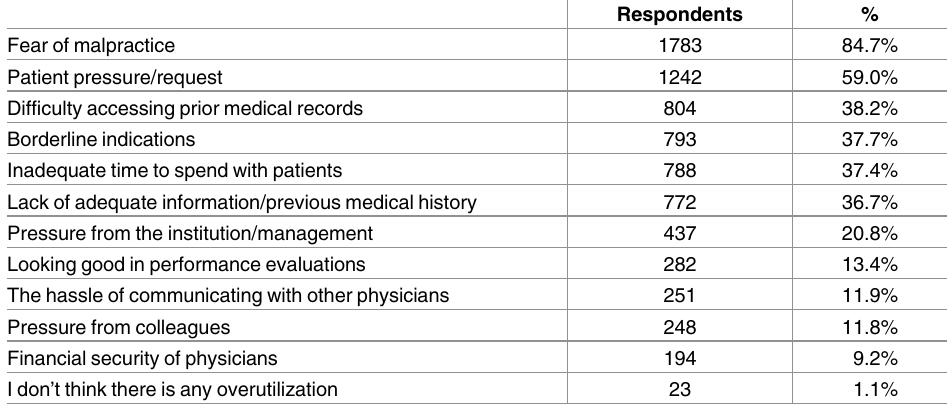
Table 2. Physician perceptions on top three reasons for overtreatment (N = 2,106).